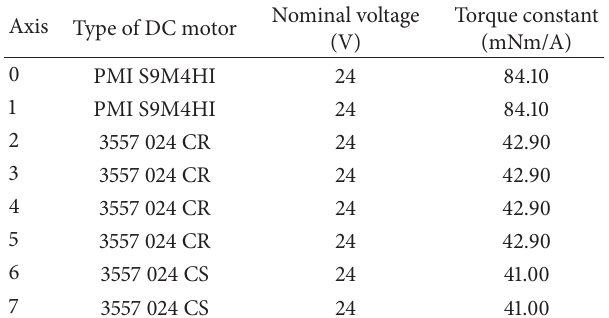
Table 2: Motor data sheet.